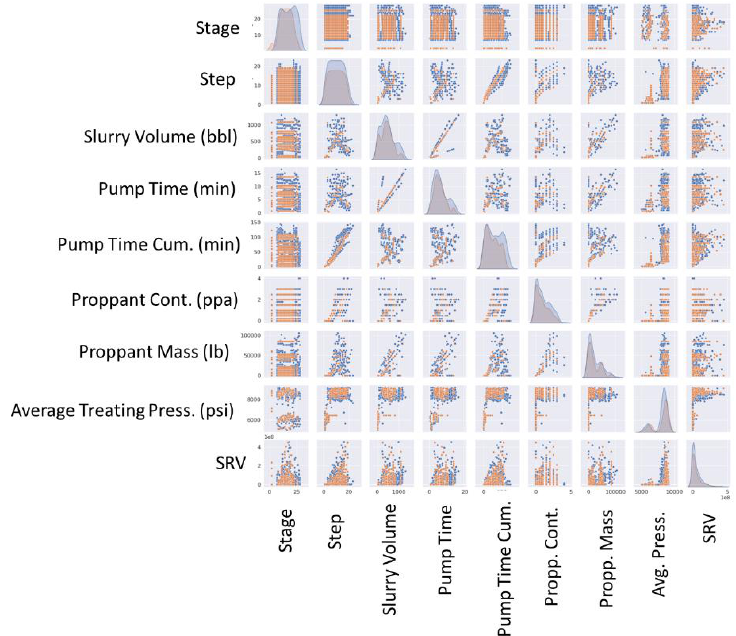
Figure 8. Scatter matrix of the final variables (blue and orange dots represent well MIP-3H and MIP-5H, respectively). Table 3. The final set of input/output. The maximum calculated SRV in this study is about ~14 times bigger than what was reported in Barnett shale [26].